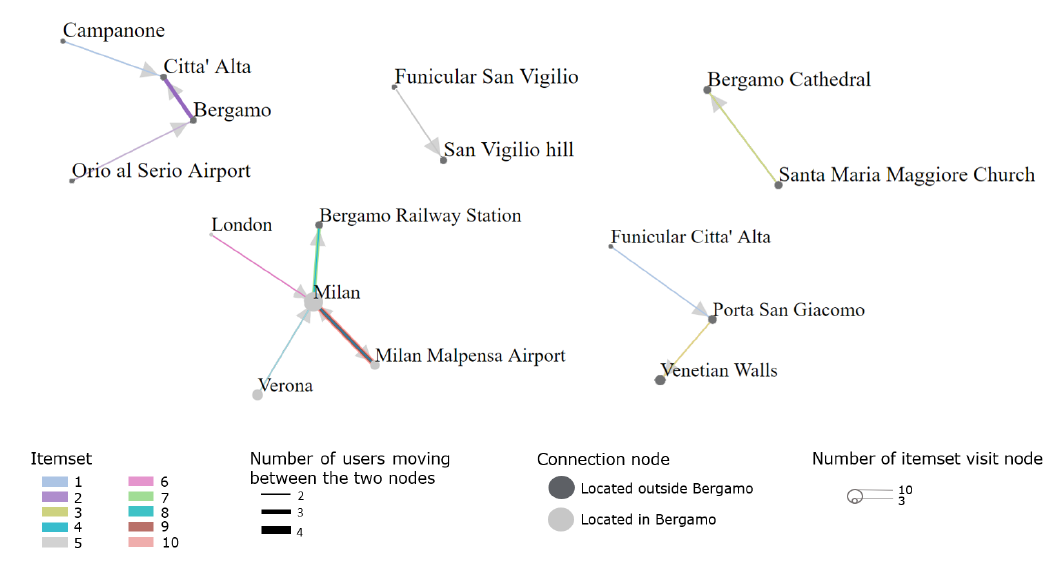
Figure 7. Topological representation for discovered itemsets associating direct transfers (Interpretation